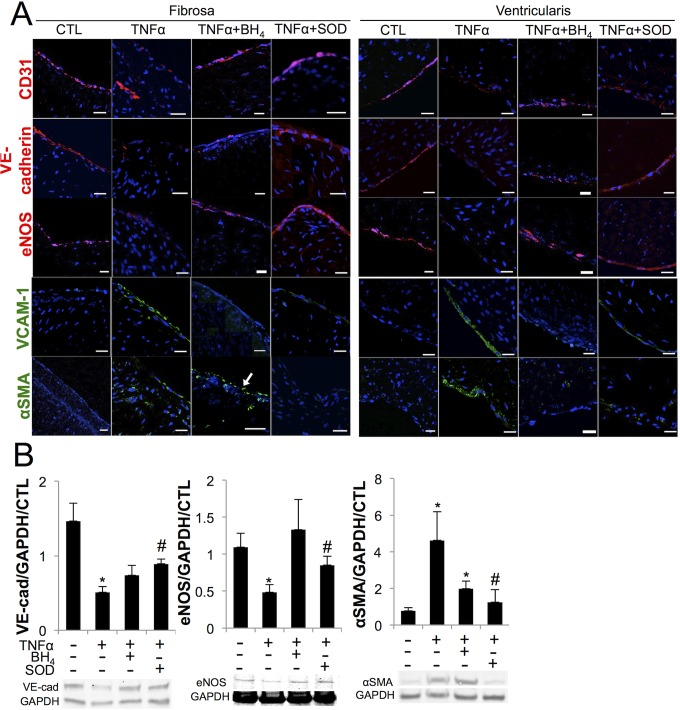
TNFα induces endothelial dysfunction, increased inflammatory activation, and myofibroblastic activation ex vivo, rescued by antioxidants.
A, In ex vivo porcine aortic valve leaflets, TNFα decreased endothelial proteins CD31, VE-cadherin, and eNOS on both sides of the valve, rescued by BH4 or peg-SOD. TNFα increased VCAM1 on both sides of the valve, mitigated by BH4 or peg-SOD. TNFα increased αSMA on both sides of the valve, which was mitigated on the fibrosa by peg-SOD but not by BH4 (arrow) and on the ventricularis by either BH4 or SOD. B, Western blot quantification confirmed loss of VE-cadherin and eNOS and increase in αSMA in TNFα condition that is rescued by BH4 or peg-SOD. * indicates p < 0.05 versus CTL, # indicates p < 0.05 versus TNFα. Scale bar = 20μm. N = 6.